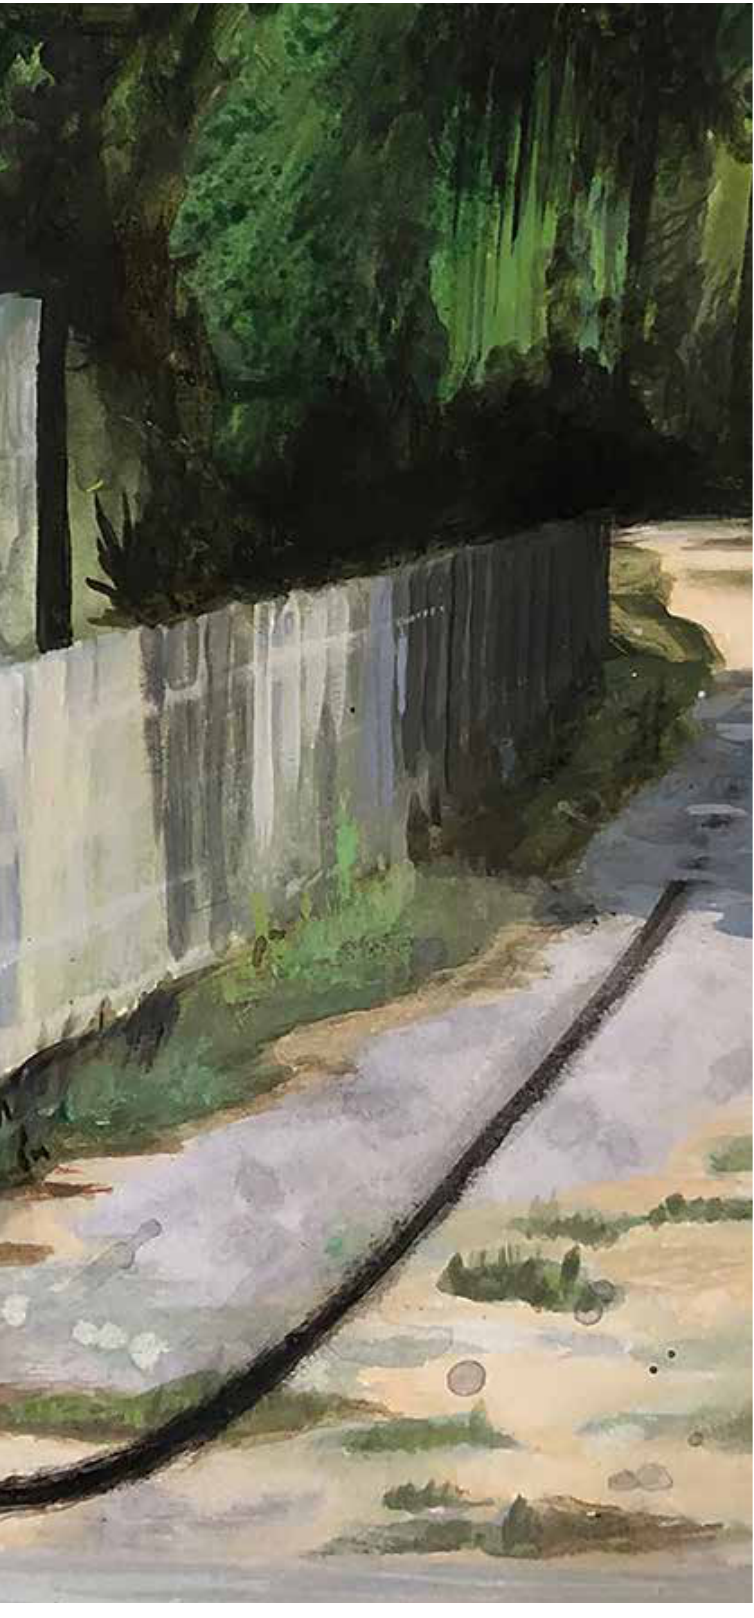
Figure 6: Denise Burge, Driveway, 2019. Acrylic on paper, 25.4 x 25.4